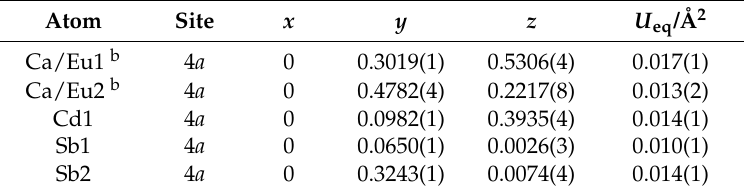
Table 5. Atomic coordinates and equivalent displacement parameters ( U eqa ) for Ca 2 − x Eu x CdSb 2 , x =